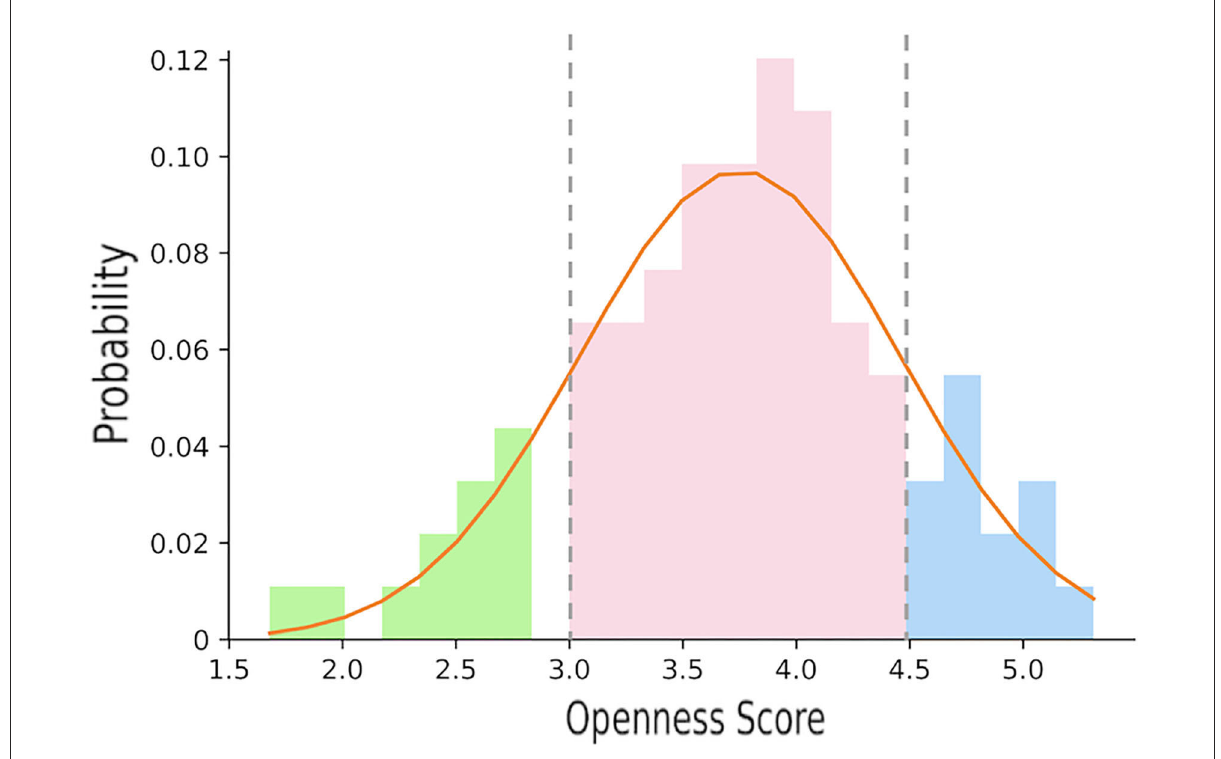
FIGURE1 The distribution of participant’s openness